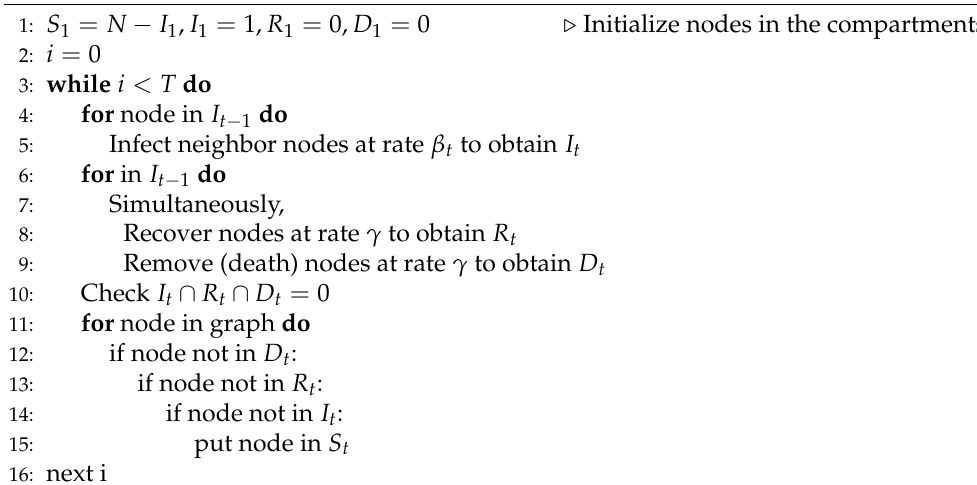
Algorithm 3 Network algorithm for the SIRD